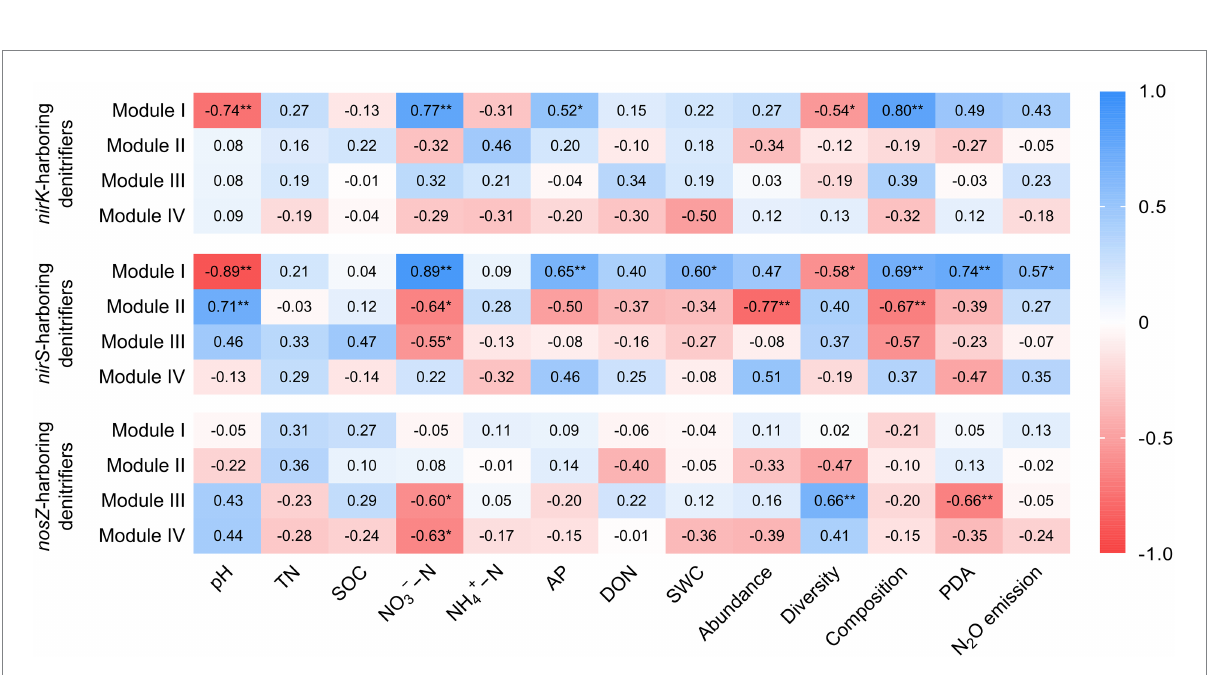
FIGURE 5 Correlation coefficients between module eigengenes, soil properties, the nirK -, nirS -, and nosZ -harboring denitrifiers, potential denitrification activity (PDA), N 2 O emission. The denitrifying communities are represented by abundance (the copy numbers of genes), diversity (Chao1 richness), and composition (first principal coordinates, PC1). Blue color indicates positive correlation, and red color indicates negative correlations. TN, total nitrogen; SOC, soil organic carbon; NO 3 − − N, nitrate nitrogen; NH 4+ − N, ammonia nitrogen; AP, available phosphorus; DON, dissolved organic nitrogen; SWC, soil water content. * p < 0.05 and ** p <